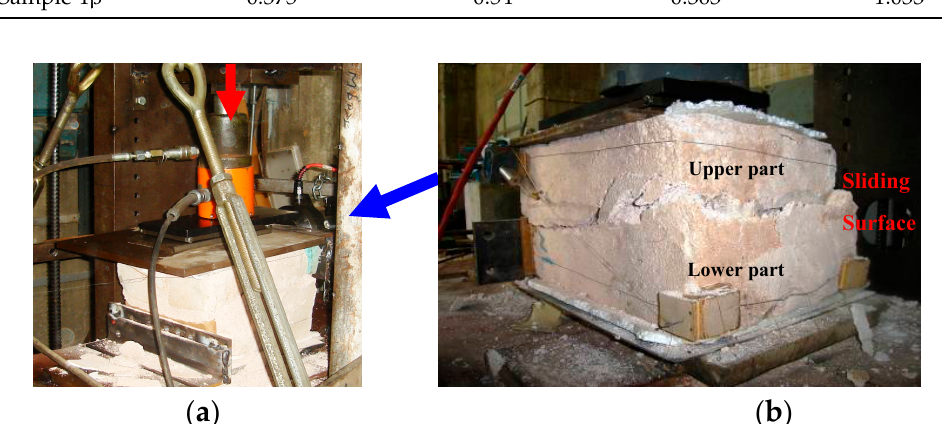
Table 1. Comparison between measured and predicted shear strength values.